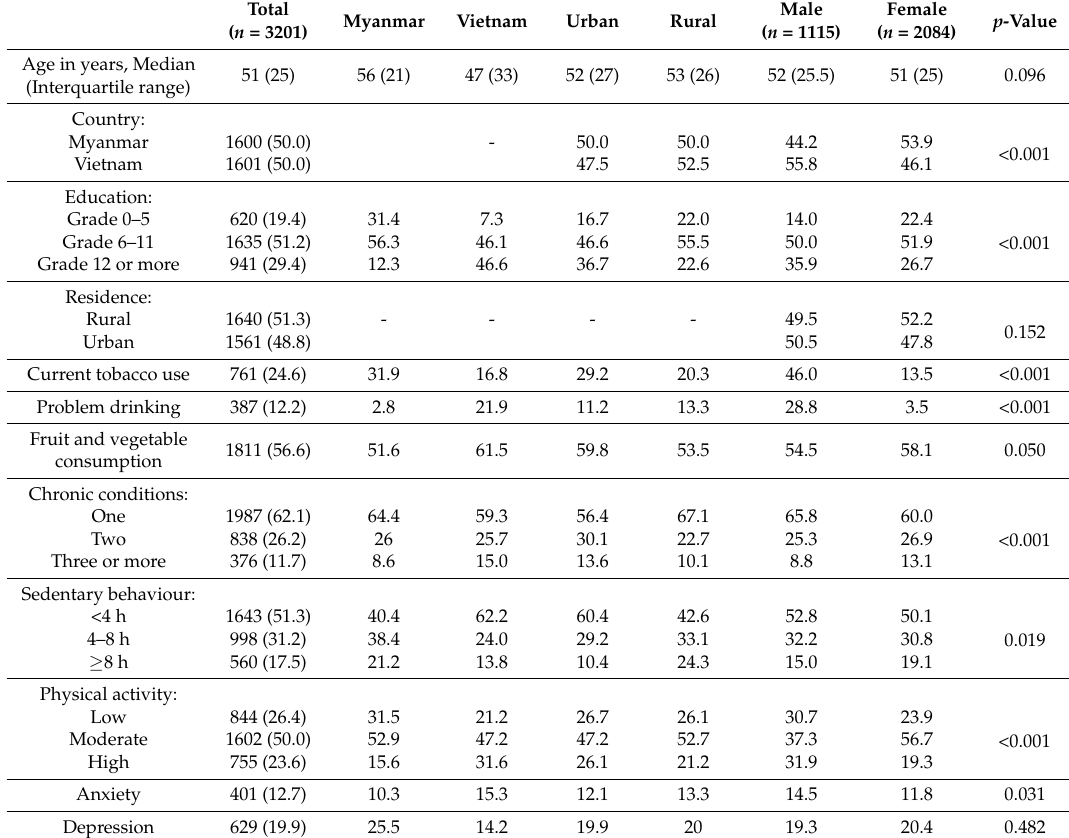
Table 1. Basic sample